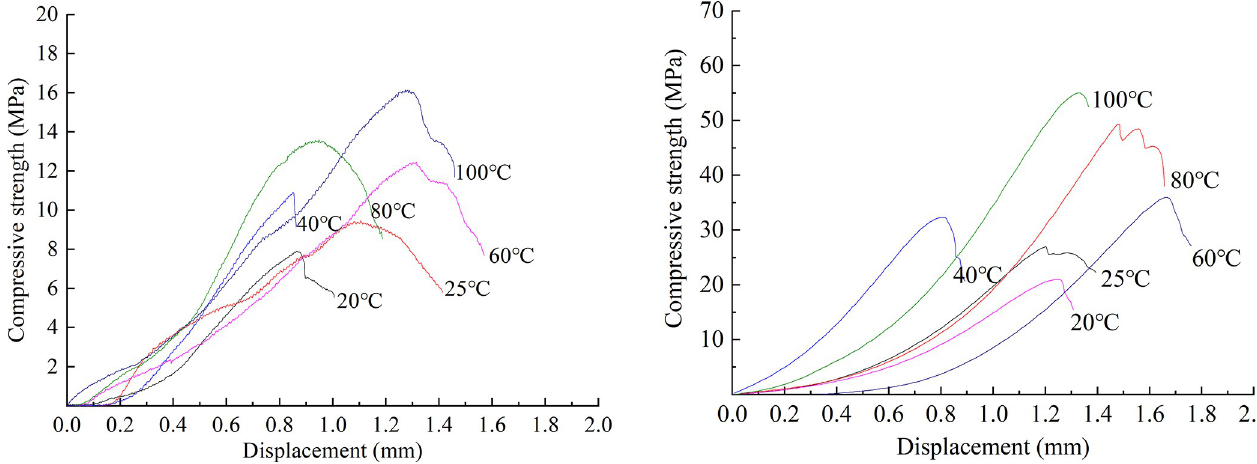
Fig 20. Stress–displacement curves of typical specimens at different temperatures. (a) Compressive strength responses of similar materials. (b) Raw rock.